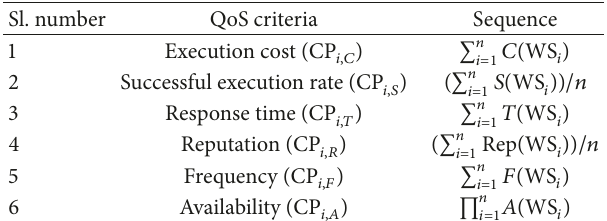
Figure 2: Travel reservation